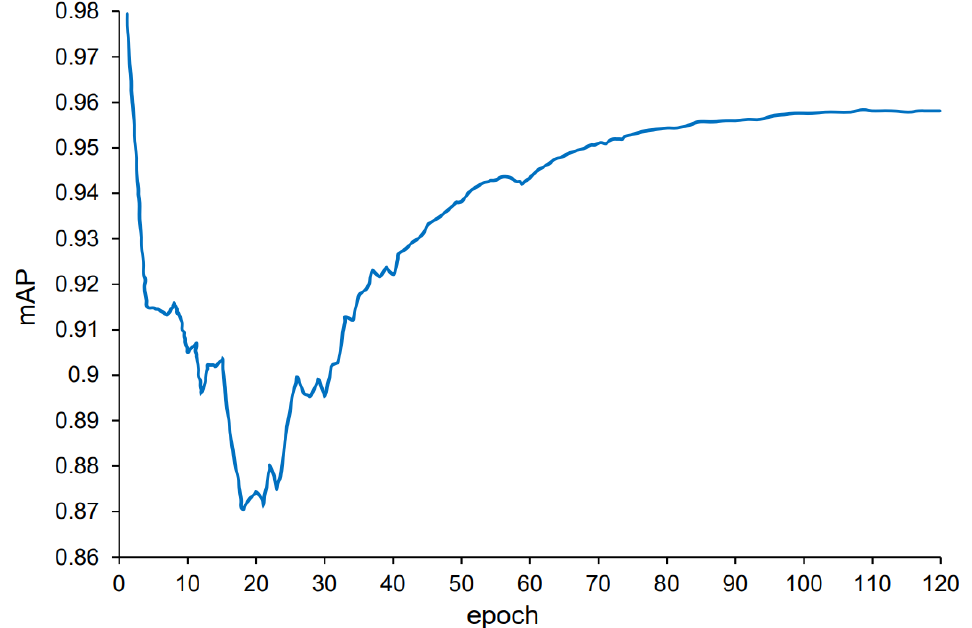
Figure 8. Plot of model mAP changes during sparse training.